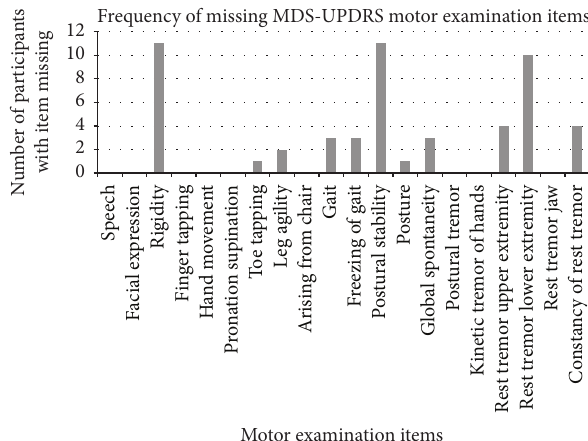
Figure 1: Frequency of missing MDS-UPDRS motor examination items during the Internet-based videoconference assessment of 11